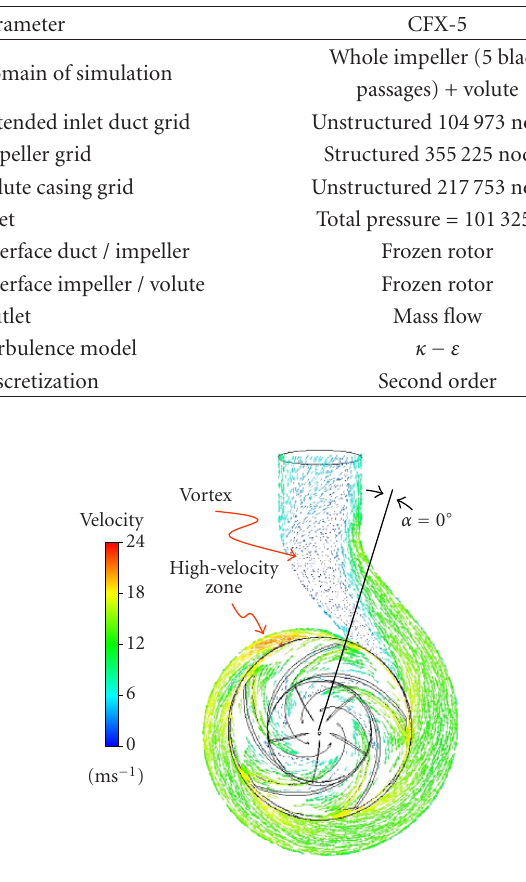
Figure 13: Velocity vectors of pump NS32 at the best e ffi ciency point ( Q/Q bep = 1) and α = 0 ◦ .